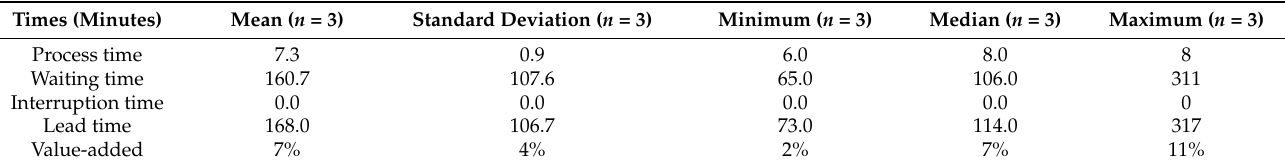
Figure 2. Value Stream Map of patients who required medication ( n = 6). In the first group, patients who left the service without being seen, a map was drawn for three patients; two of them were classified as green and one as blue. These patients had been classified by the nurse and were waiting for the medical screening; however, the three patients left before the medical consultation. The times measured during this process are presented in Table 1. Table 1. Process, interruption, waiting, and lead times and value-added obtained by the Value Stream Maps of patients who left the service without being seen ( n = 3).